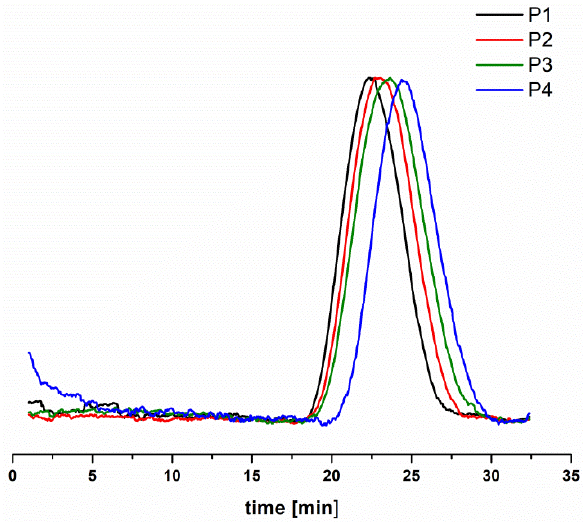
Figure 2. Chromatograms (RI traces) of P(DMAEMA- co -OEGMA-OH) star copolymers (DMF, 1 mL/min).